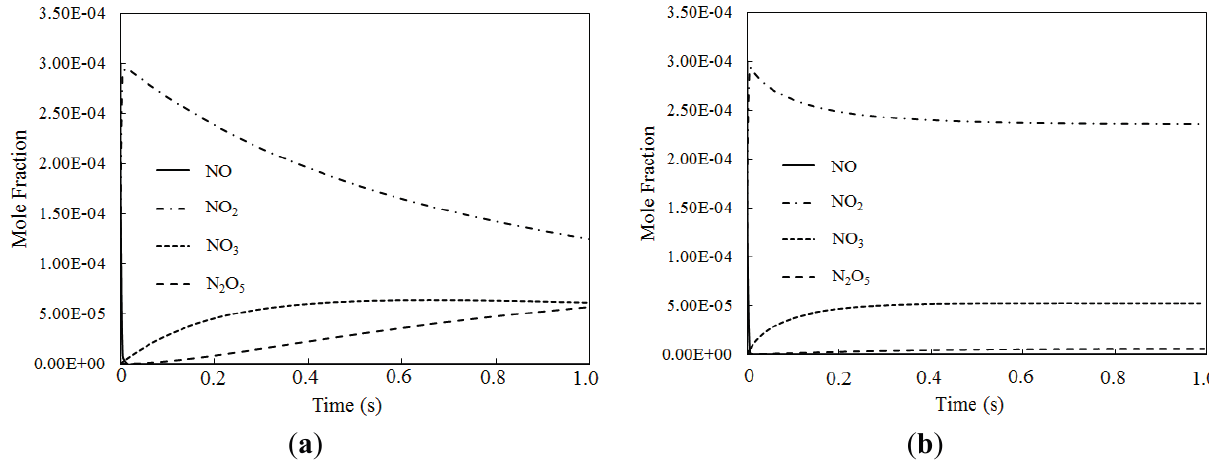
Figure 10. The mole fraction variations for NO, NO 2 , NO 3 and N 2 O 5 of different temperatures where O 3 /NO concentrations equal 1.5 for T = 100 °C and T = 200